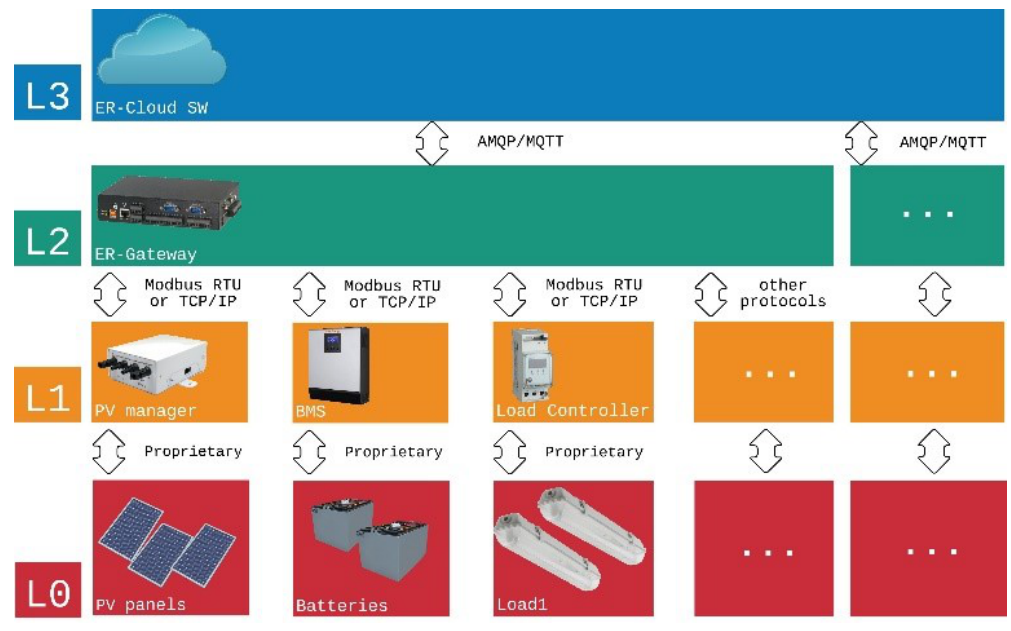
Figure 1. Multilayer scheme of the “Energy Route”